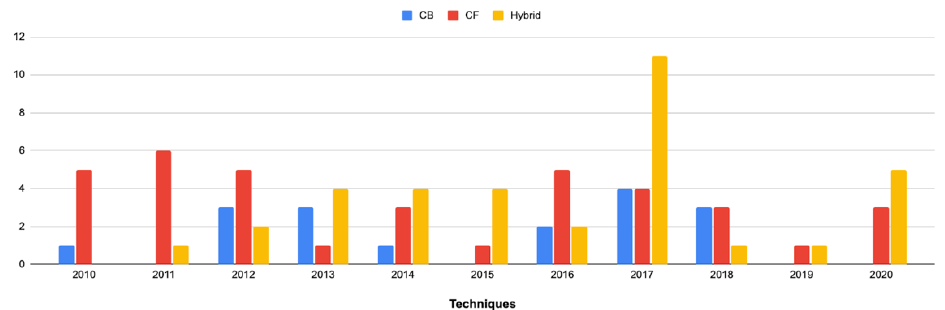
Figure 10. Trend by recommendation model of recommendation system research of papers collected according to this study standard.